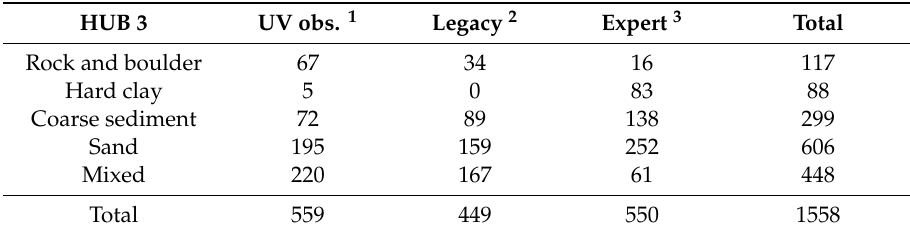
Table A4. Distribution of the ground-truth dataset divided into HUB 3 classes. HUB 3